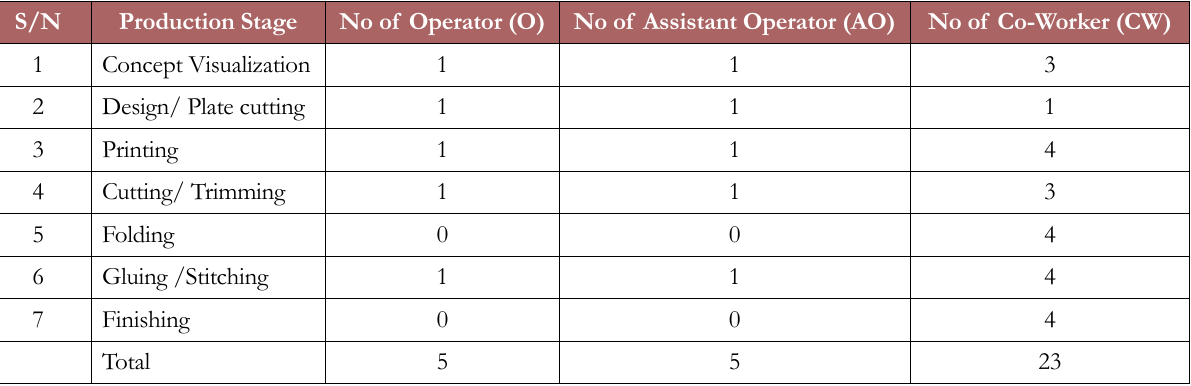
Table 6. Present Labour of AB Production line